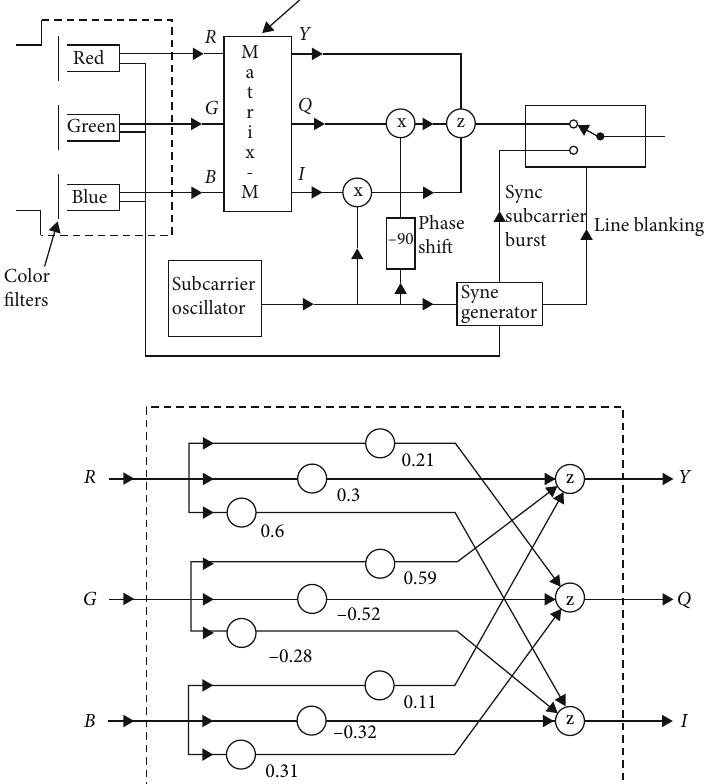
Figure 3: Conversion RGB to NTSC using matrix M [12].